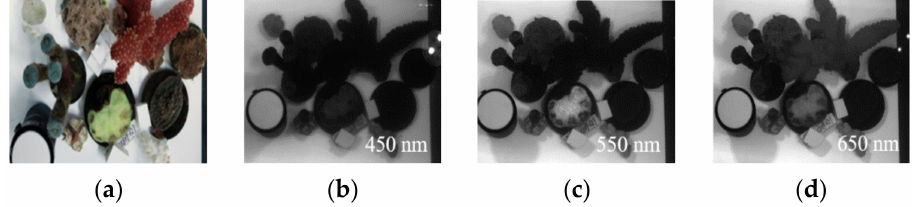
Figure A4. ( a ) Coral species including the dead coral skeleton; ( b – d ) Spectral images under white light illumination.